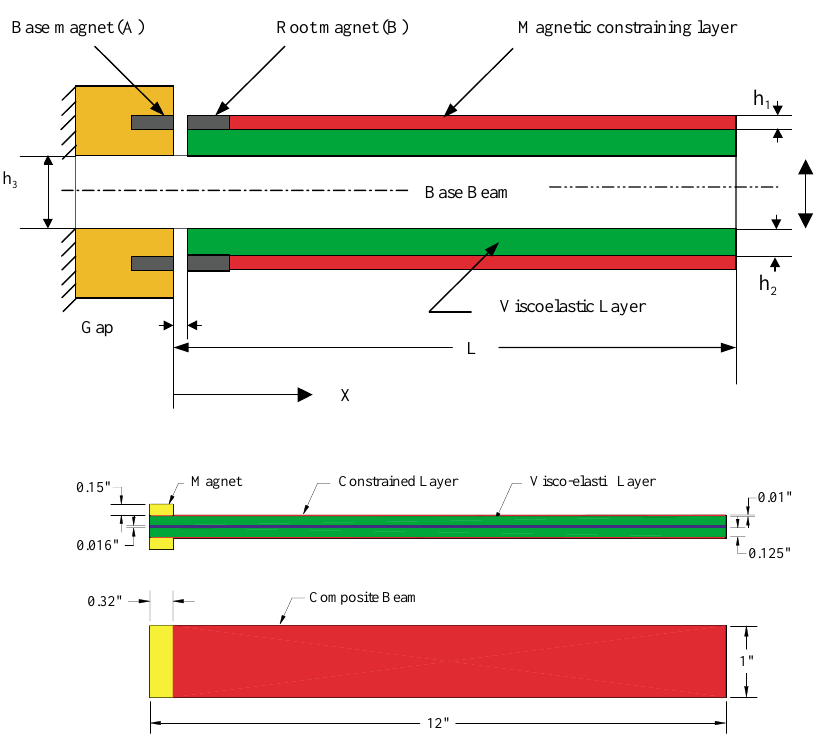
Fig. 3. Main geometric parameters of a full magnetic constrained layer damping treatment for cantilvered beam with base magnets. beams treated with MCLD is presented by Baz [2]